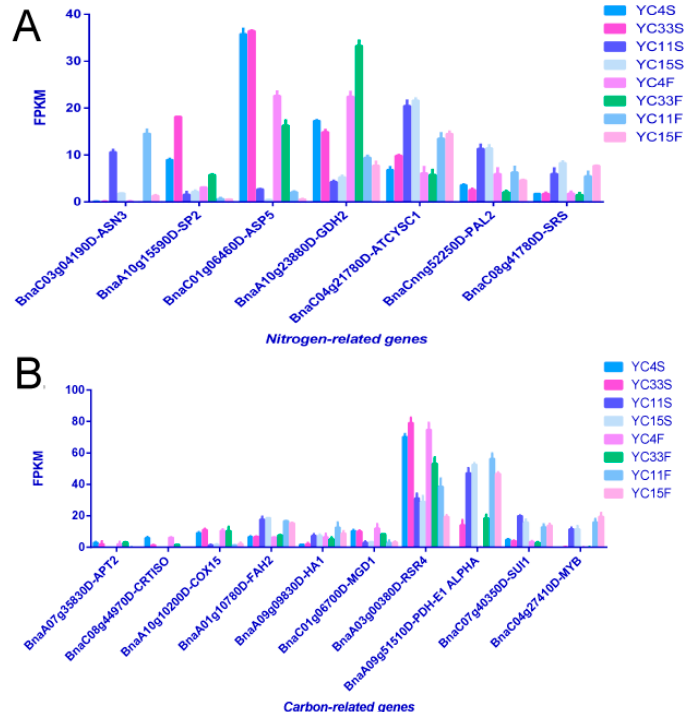
Figure 6. Many DEGs as key enzymes related to the nitrogen ( A ) and carbon ( B ) metabolisms. The expression value on the y-axis is derived from the fragments per kilobase of exon per million fragments mapped (FPKM) of RNA-Seq data.